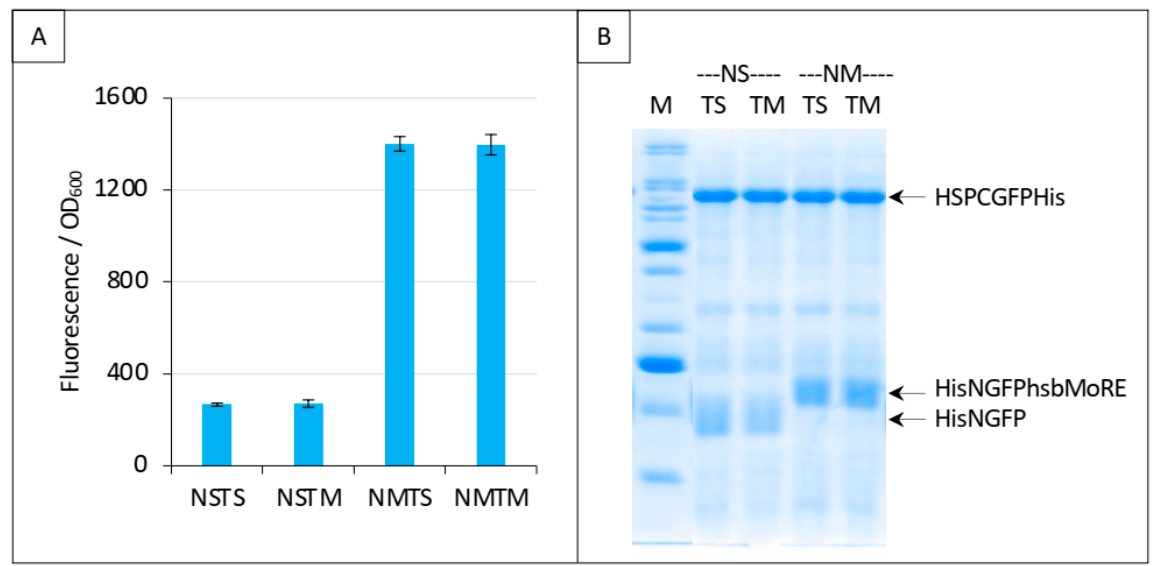
Figure 11. Split-GFP reassembly competition assay using NGFP-hsbMoRE, HSP-CGFP, and hsbMoRE as competitor. Experimental conditions are the same as those described in Figure 9C, ex- cept that TH is replaced with TM (hsbMoRE competitor expressed by p17Tet). ( A ) Fluorescence data. ( B ) SDS-PAGE analysis of protein expression. M, molecular mass markers (200, 150, 100, 85, 60, 50, 40, 30, 25, 20, 15, 10 kDa).